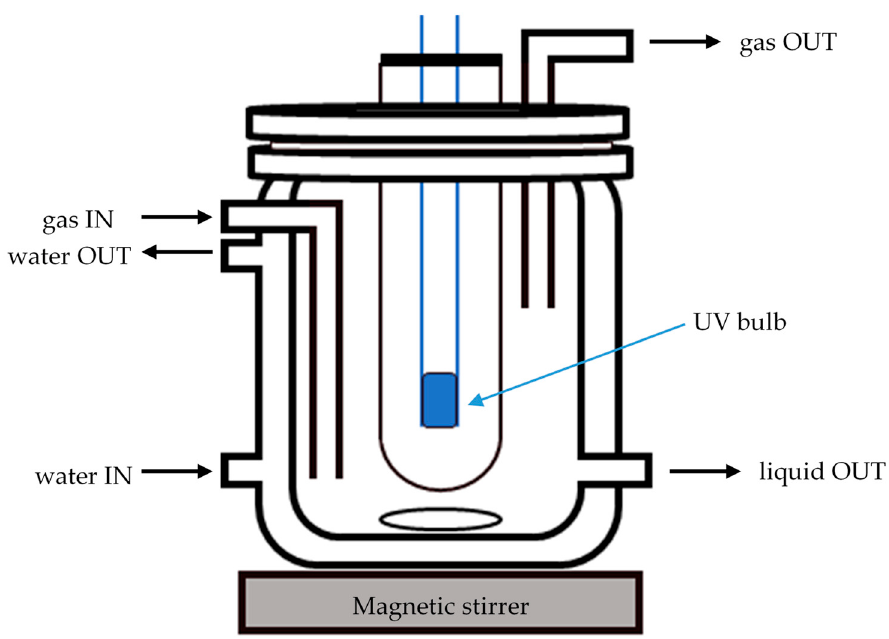
Figure 10. Simplified scheme of the reactor in the sealed configuration.